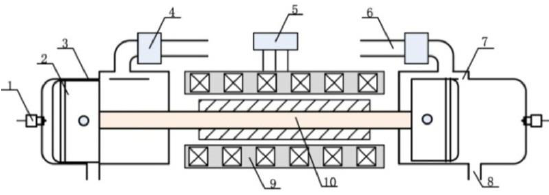
Figure 1. The structure of the FPLG prototype. 1. Spark plug; 2. Piston; 3. Cylinder; 4. Fuel injector;